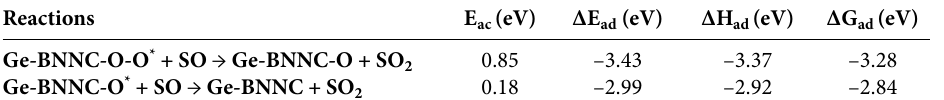
Table 2. Obtained parameters for Ge-BNNC-O-O * + SO → Ge-BNNC-O + SO 2 and Ge-BNNC-O * + SO → Ge-BNNC + SO 2 reactions.